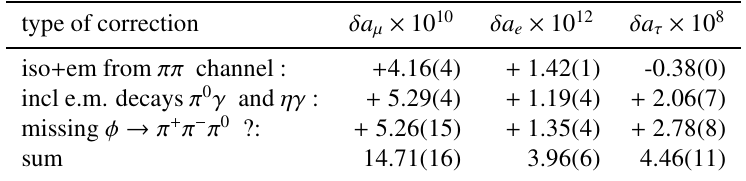
Table 5. Neutral channel: total shifts for a ℓ ( ℓ = µ, e ,τ